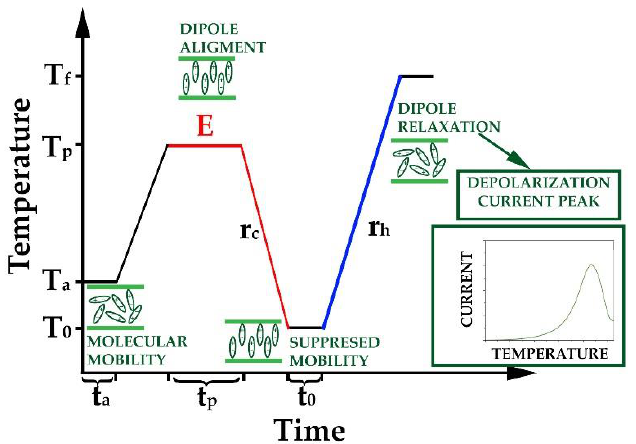
Figure 2. Schematic drawing of the applied measuring process. (Red lines indicate the part of the measurement where field strength (marked with red E) was turned on. The blue line indicates the depolarization step when the depolarization current was recorded. The green partial figures show the arrangement of the dipoles during the different processing steps.